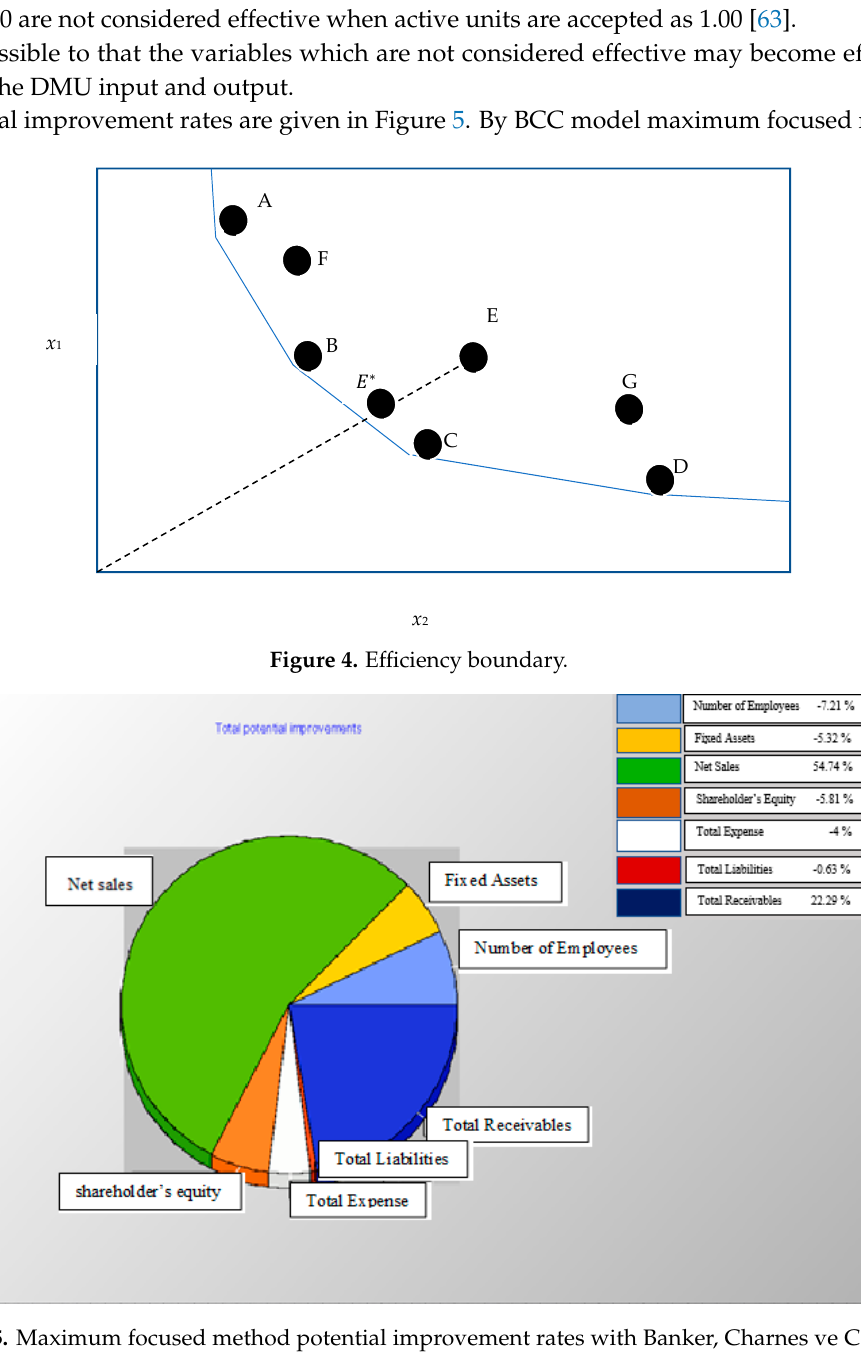
Figure 5. Maximum focused method potential improvement rates with Banker, Charnes ve Cooper (BCC) Model.